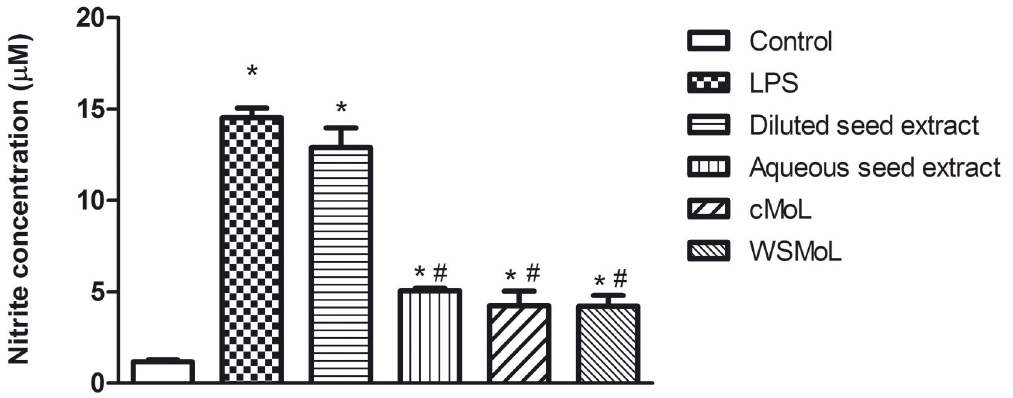
Figure 1. Effect of M. oleifera seed extracts and lectins (cMoL and WSMoL) on nitric oxide production by murine macrophages stimulated with LPS. Data are presented as mean ± standard deviation of three independent experiments. *p<0.05 compared to control (cells in medium culture only) by ANOVA followed by Newman-Keuls test. #p<0.05 compared to LPS by ANOVA followed by Newman-Keuls test.